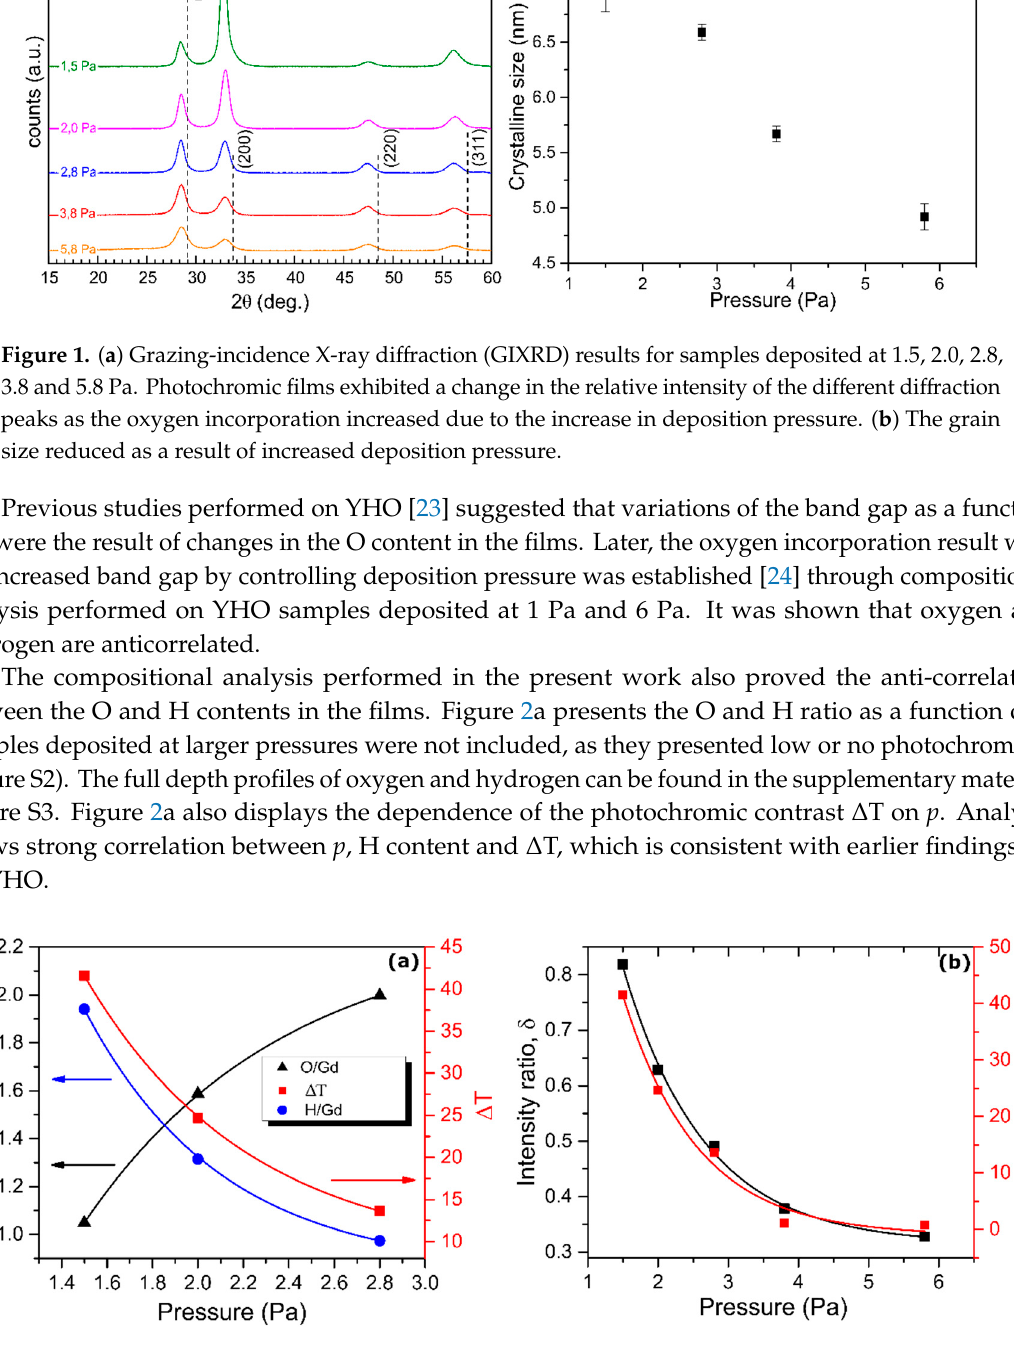
Figure 2. ( a ) Composition of photochromic GdHO films and optical contrast Δ T as a function of deposition pressures. Optical contrast Δ T is averaged over wavelength 550 nm to 1000 nm. ( b ) Intensity ratio δ and Δ T as a function of deposition pressure. Curves are visual guides.